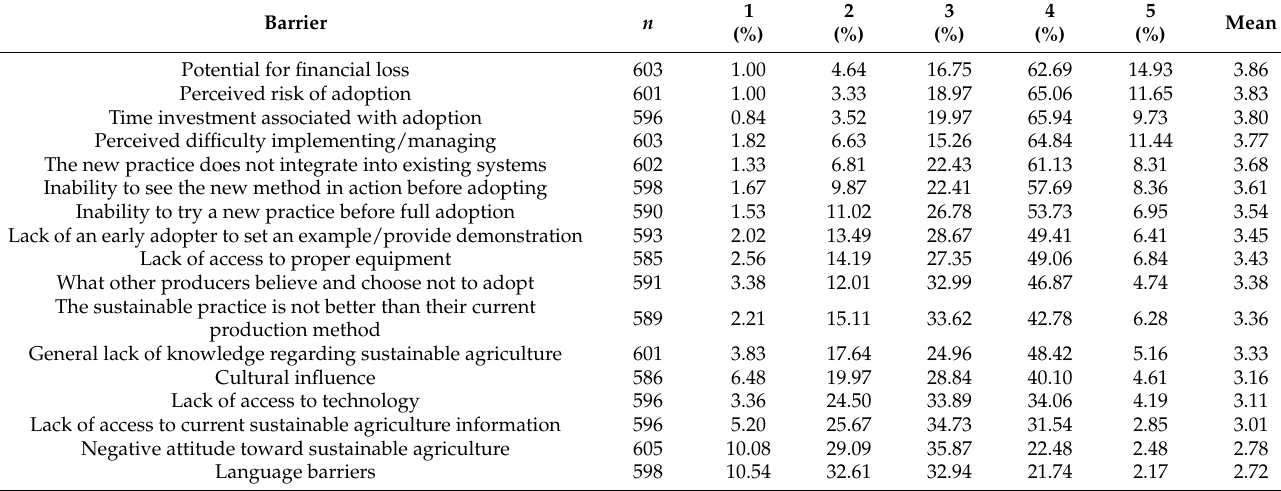
Table 3. Sustainable agricultural practices barriers to